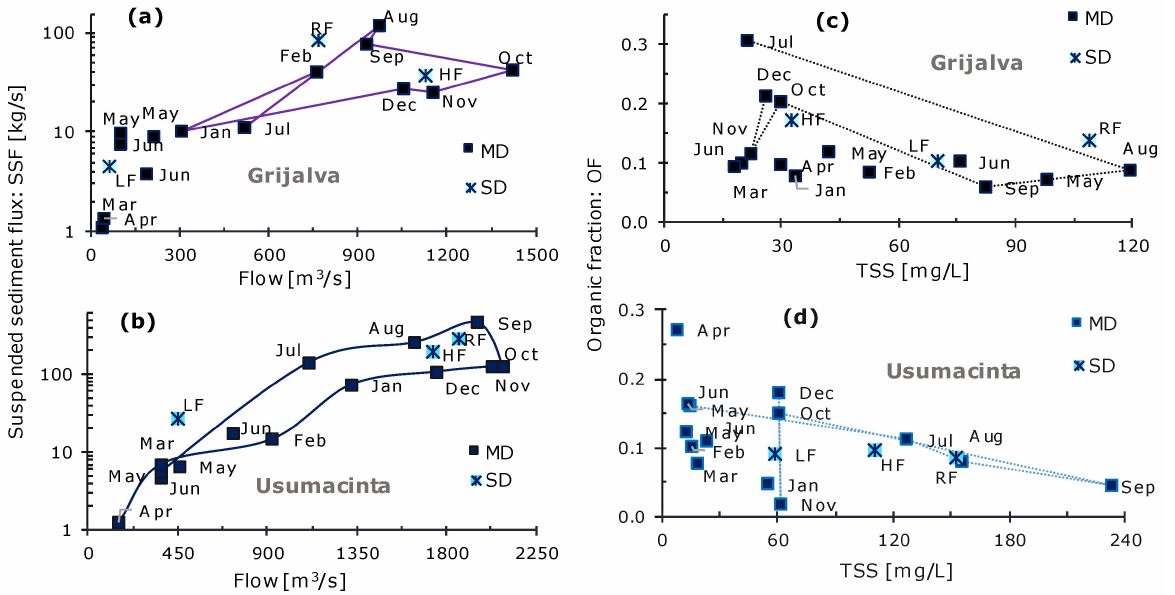
Figure 4. Intra-annual variability in suspended load: ( a , b ) Hysteresis patterns in suspended sediment flux (SSF); ( c , d ) Organic Fraction (OF) vs. mean total suspended solids (TSS). MD: Monthly data (from May 2016 to June 2017), SD: Seasonal data (2021–2022), HF: High-flow (November 2021), LF: Low-flow (April 2022), RF: Raising-flow (August